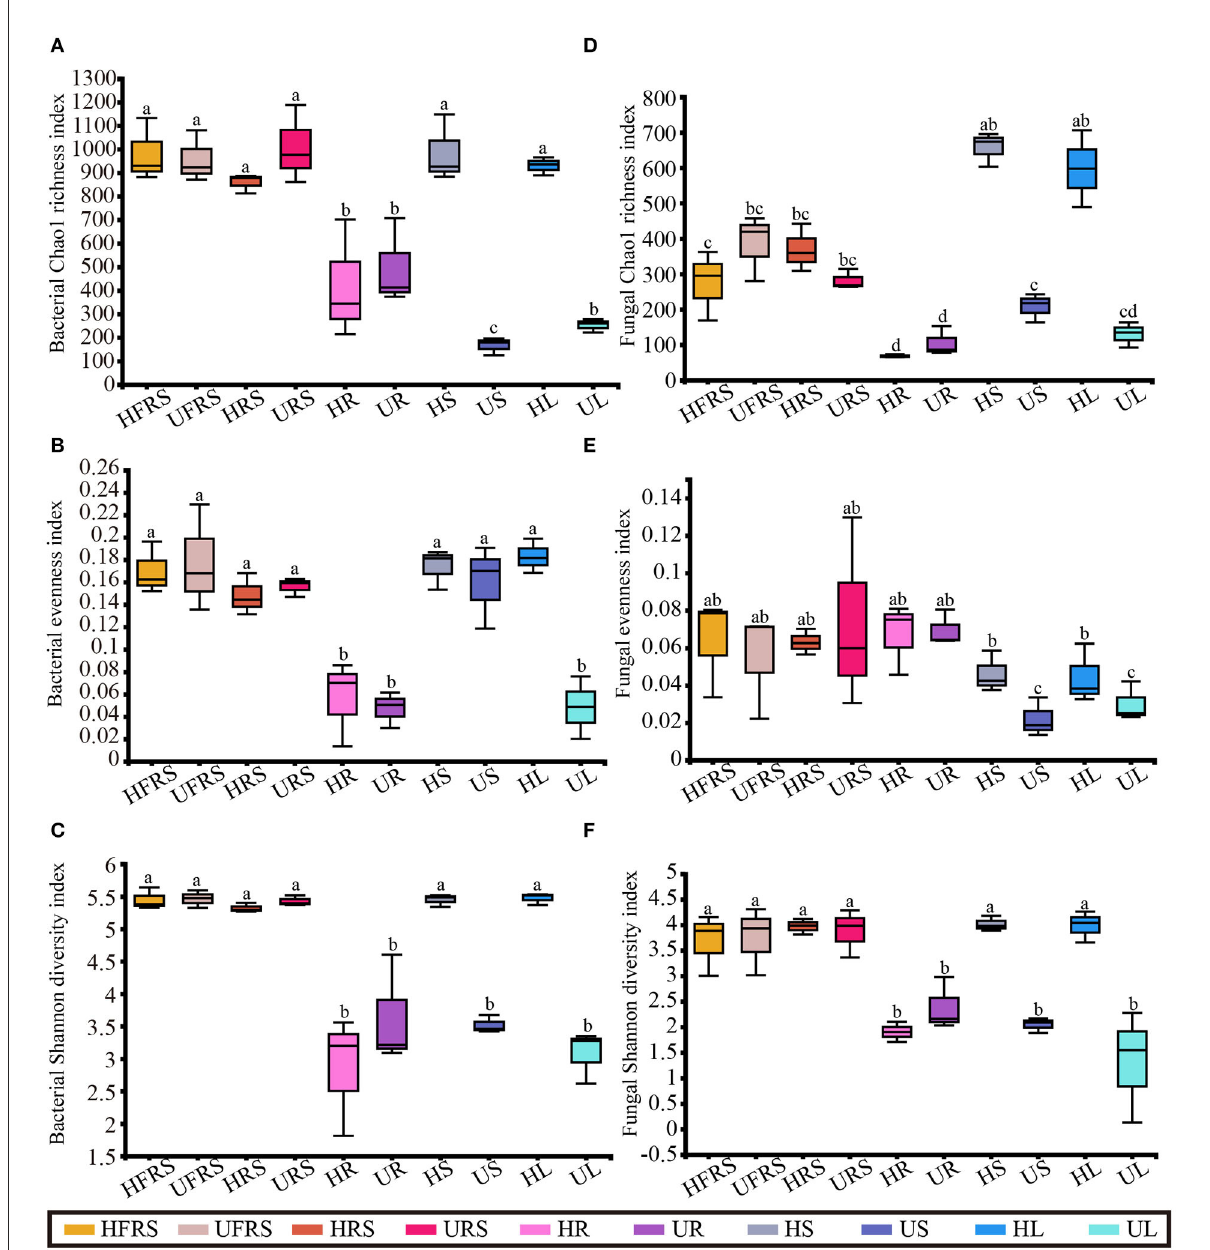
FIGURE1 Microbial alpha diversity in healthy and unhealthy P. bungeana plants. (A) Bacterial Chao1 richness index. (B) Bacterial evenness index. (C) Bacterial Shannon diversity index. (D) Fungal Chao1 richness index. (E) Fungal evenness index. (F) Fungal Shannon diversity index. All the diversity indices were calculated at the OTU level. The box plots depict the first (25%) and third (75%) quartiles, the median, mean, and the maximum and minimum observed values within each data set. The alpha diversity estimates represent the results of three biological replicates for each group. The data were analyzed by one-way ANOVA and Tukey–Kramer post-hoc comparisons. Significant differences ( P < 0.05) across plant compartments are indicated with lowercase letters. HFRS, healthy bulk soil; HRS, healthy rhizosphere soil; HR, healthy roots; HS, healthy stems; HL, healthy leaves; UFRS, unhealthy bulk soil; URS, unhealthy rhizosphere soil; UR, unhealthy roots; US, unhealthy stems; UL, unhealthy